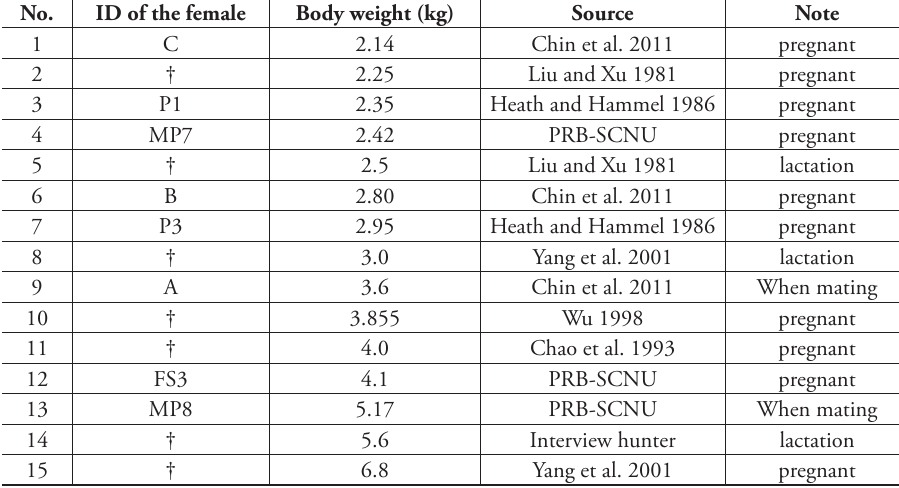
Table 4. Weight of the collected female Chinese pangolins which have the ability to reproduce in this